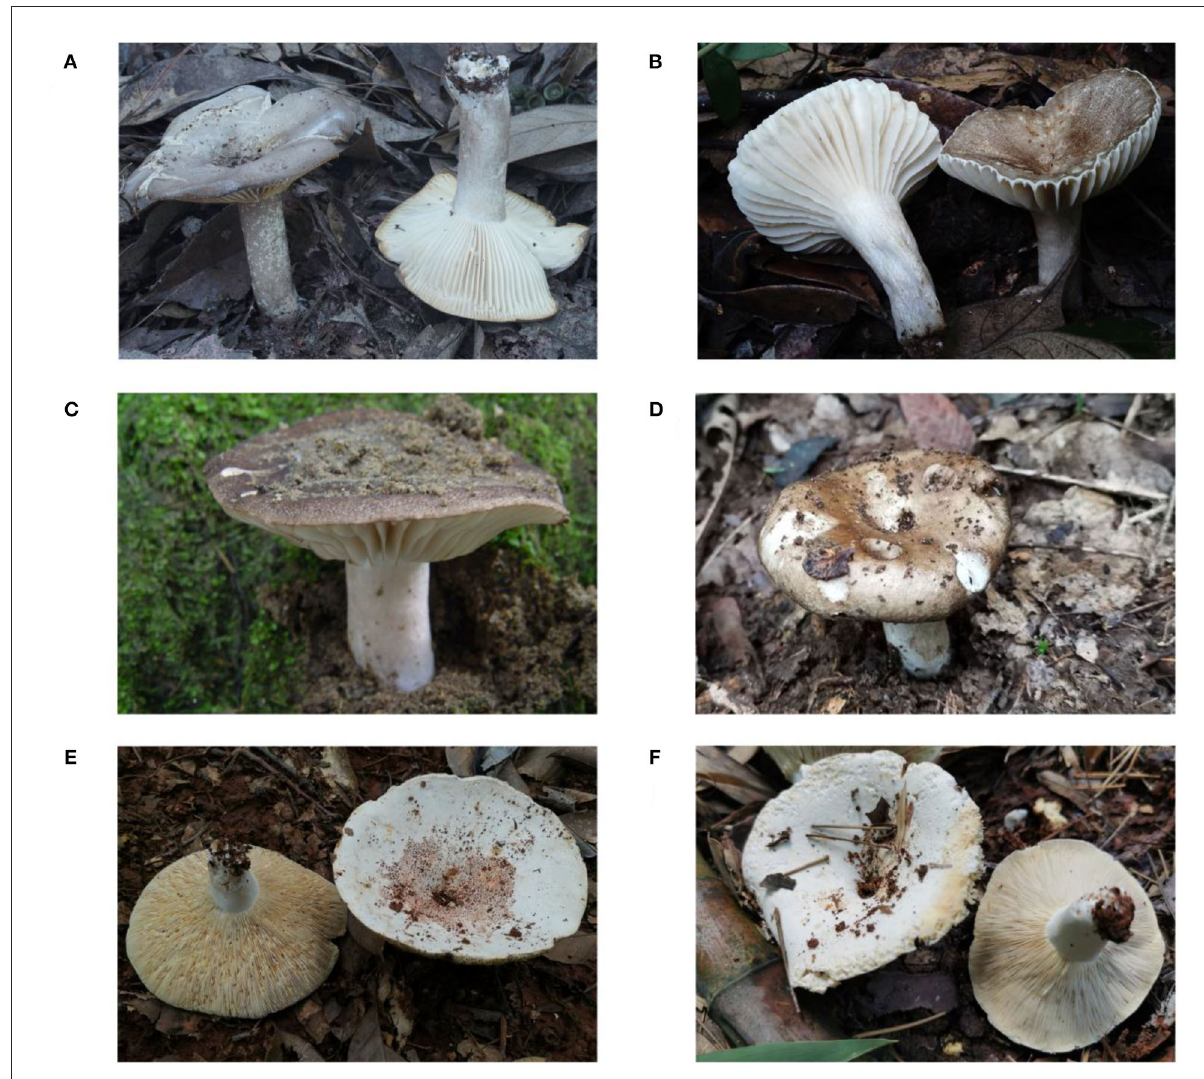
FIGURE1 Basidiomata of Russula species. (A) and (B) : Russula subnigricans ; (C) : R. nigricans ; (D) : R. densifolia ; and (E) and (F) : R. japonica